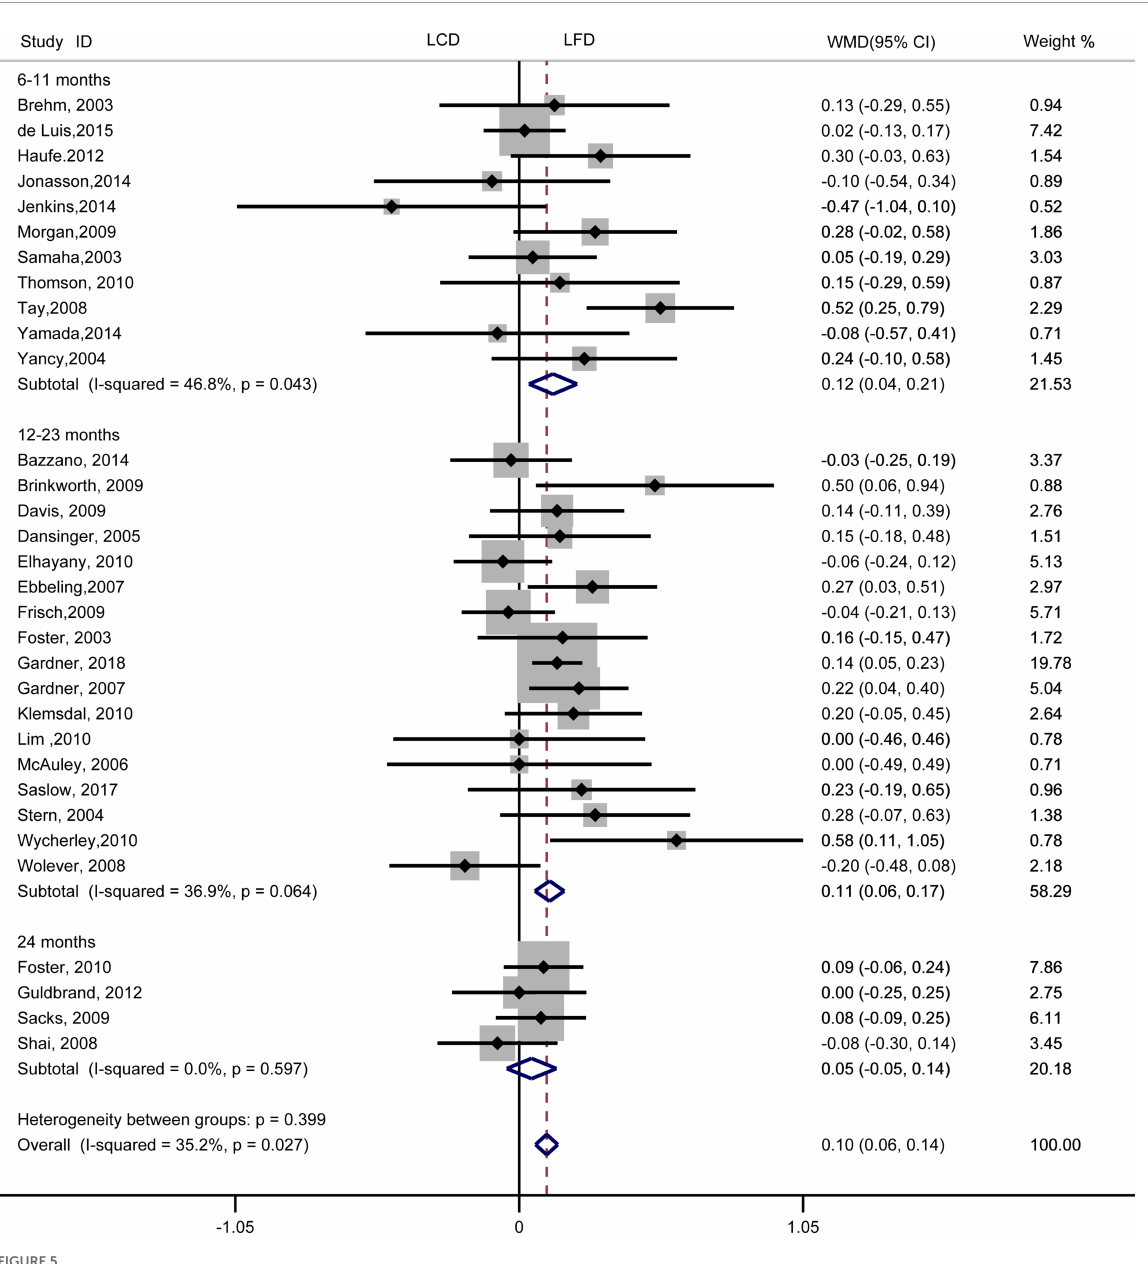
FIGURE5 Forest plots showing weight mean differences (WMD) and 95% CI for LDL-cholesterol of the low-carbohydrate diets (LCD) in comparison with low-fat diets